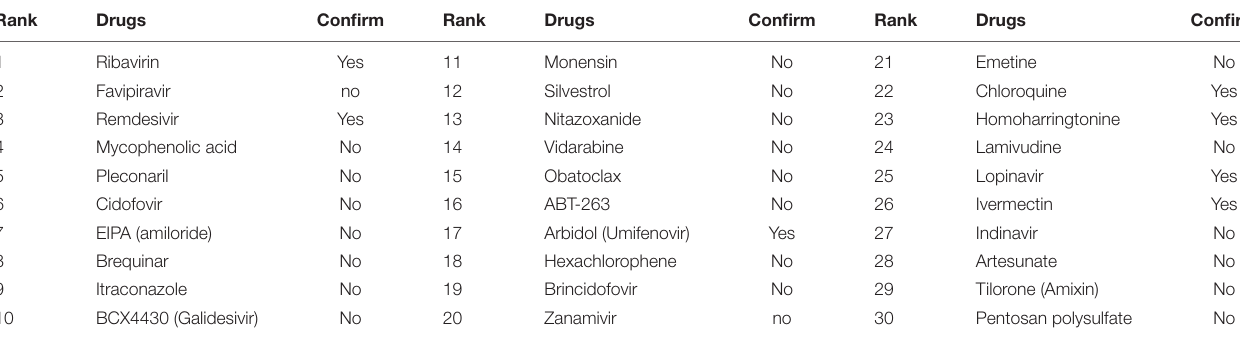
FIGURE 4 | The results by 20 times fivefold CV. (A) ROC curve. (B) Precision-Recall curve. TABLE 5 | The TOP 30 predicted drugs associated with the de novo virus SARS-COV-2.